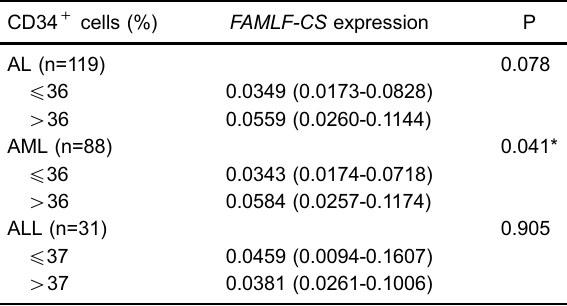
AL: acute leukemia; AML: acute myeloid leukemia; ALL: acute lymphocytic leukemia. Data are reported as medians and interquartile ranges. *P o 0.05, Mann-Whitney U